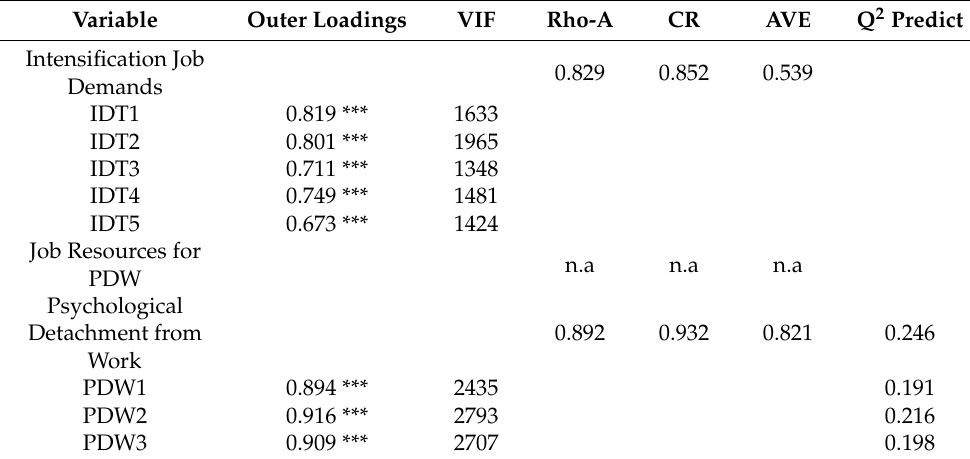
Table 4. Measurement model statistics.